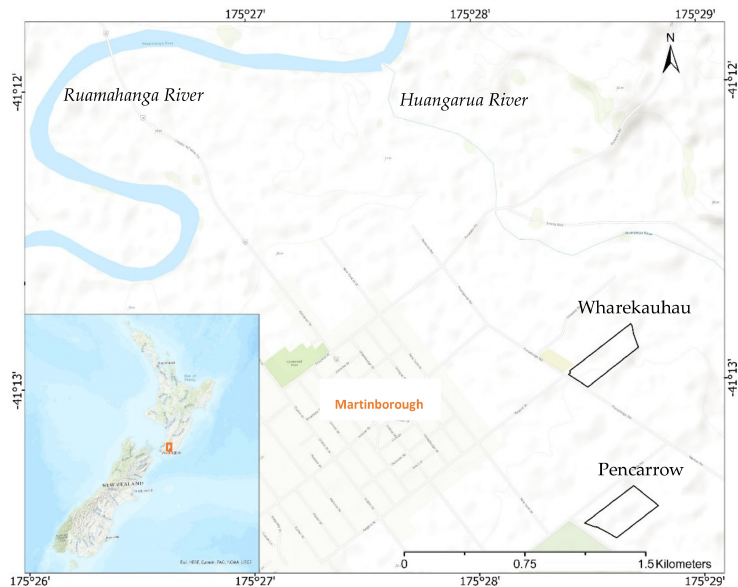
Figure 1. Location of study vineyards.